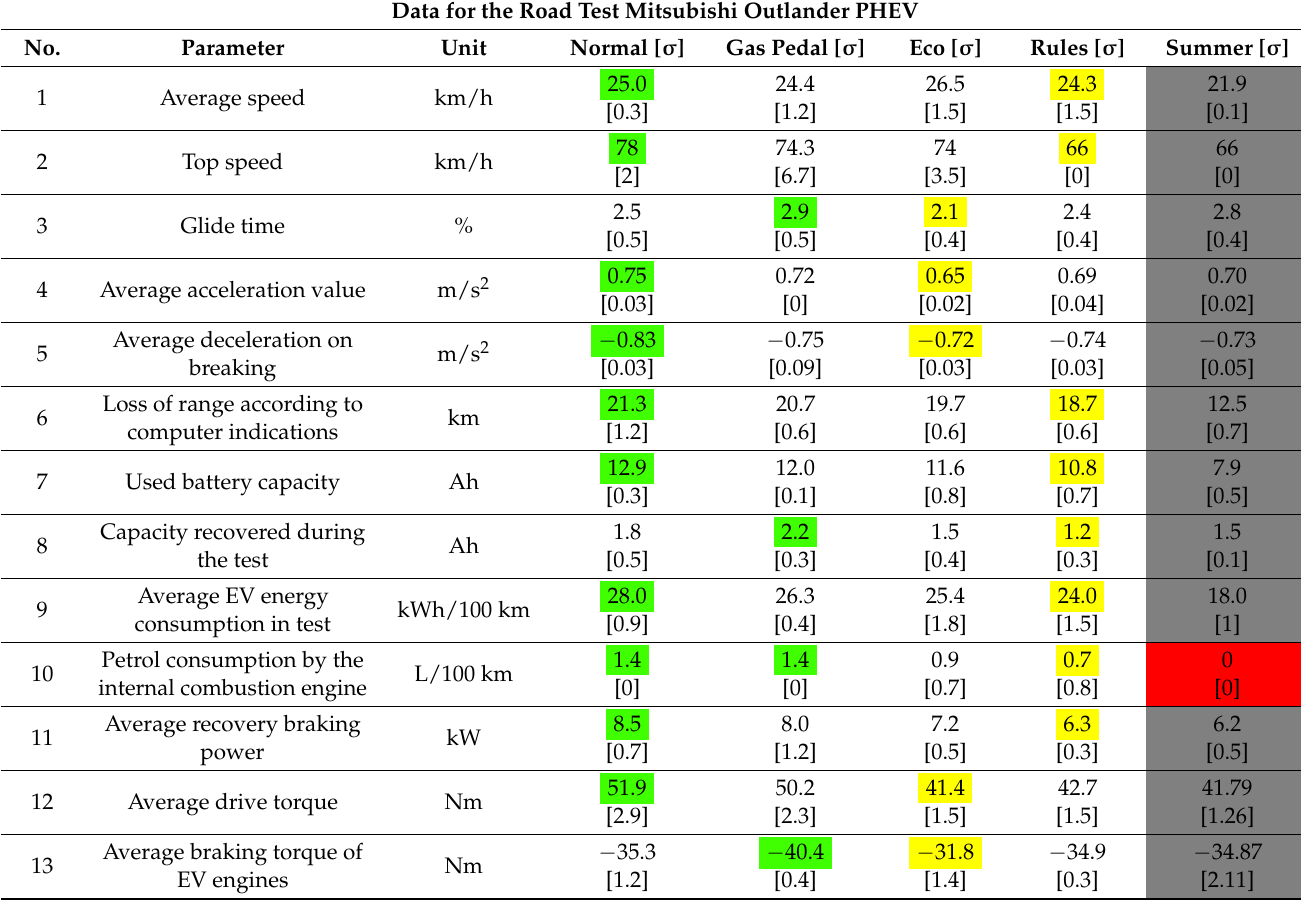
Table 4. Mean values from the test runs, green is used to mark maximum values and yellow to mark minimum values. Data for the road test. These values are calculated as approximate and predicted—based on the road tests carried out. Data for the Road Test Mitsubishi Outlander